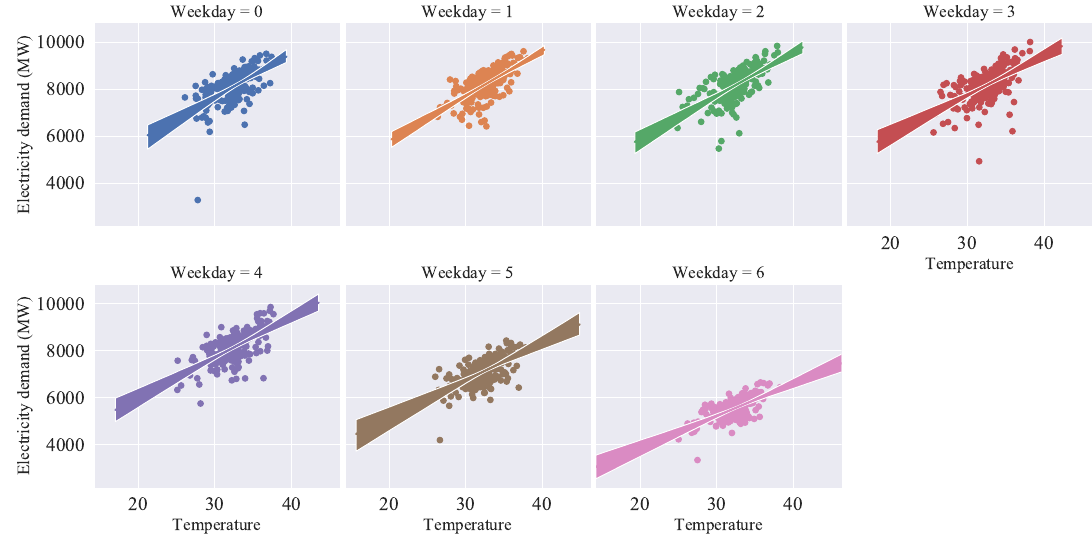
Figure A6. Effect of temperature for electricity demand on working day at peak hour: 2